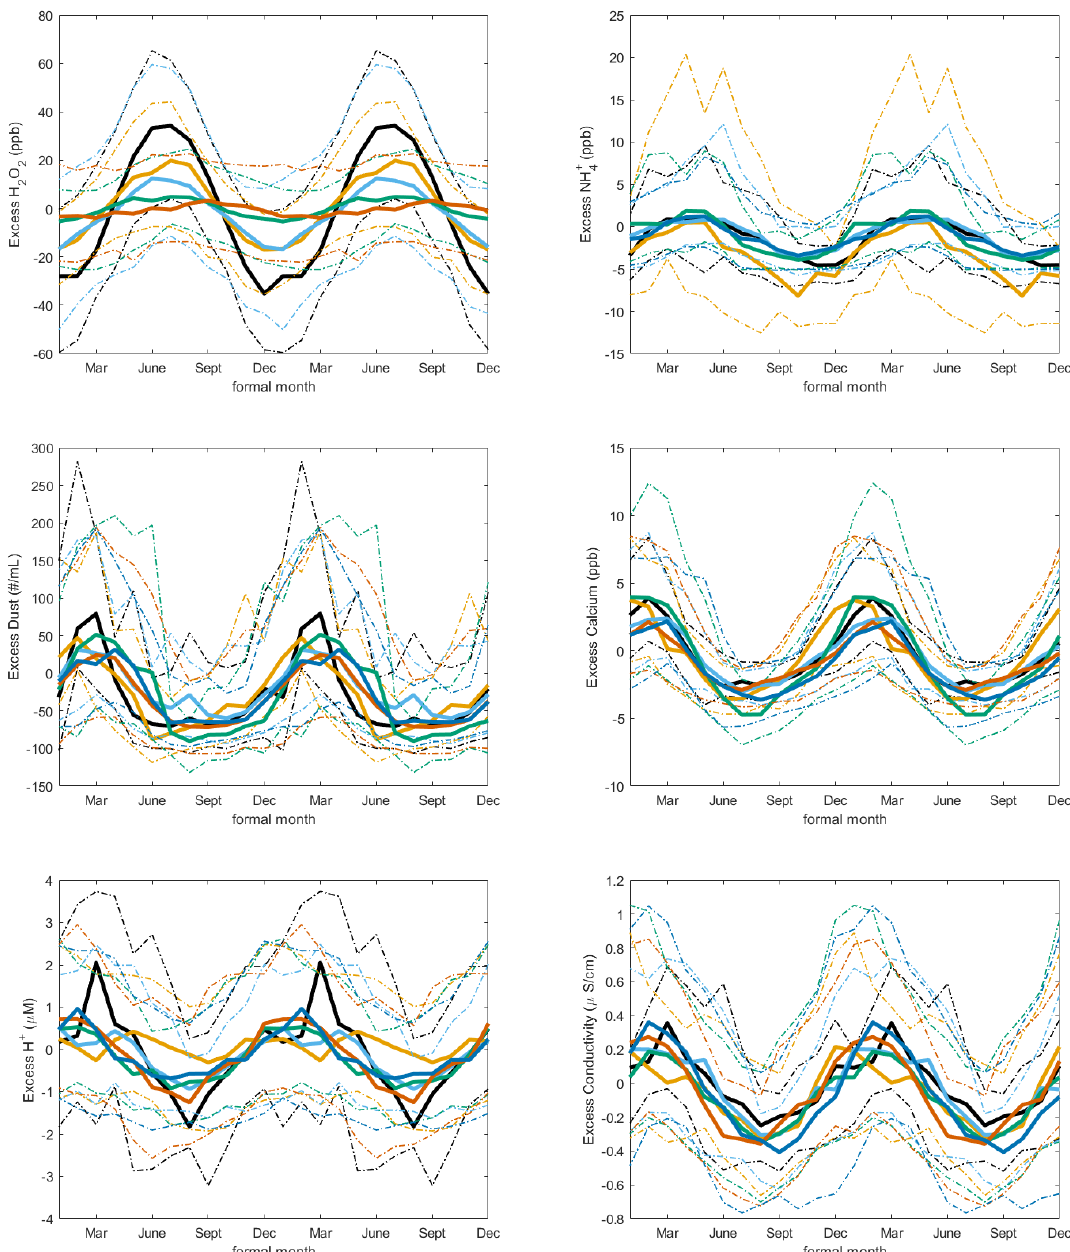
+ , insoluble dust, Ca 2 + , H + and conductivity 4